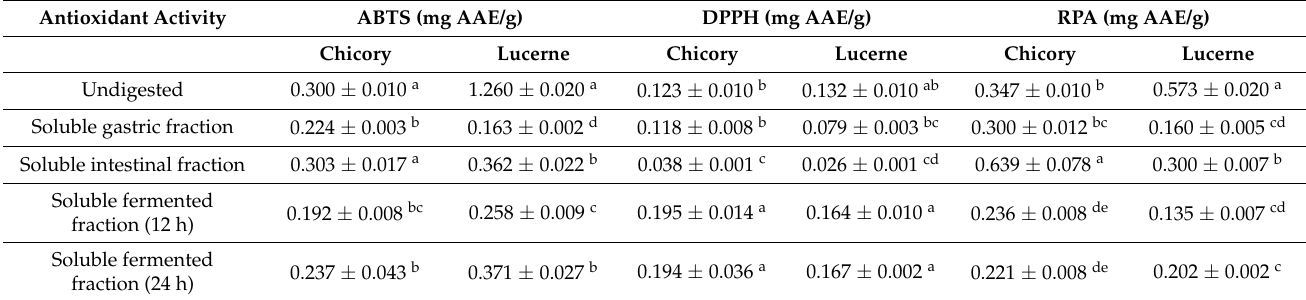
Table 4. Antioxidant activities of undigested chicory and lucerne and their digestive